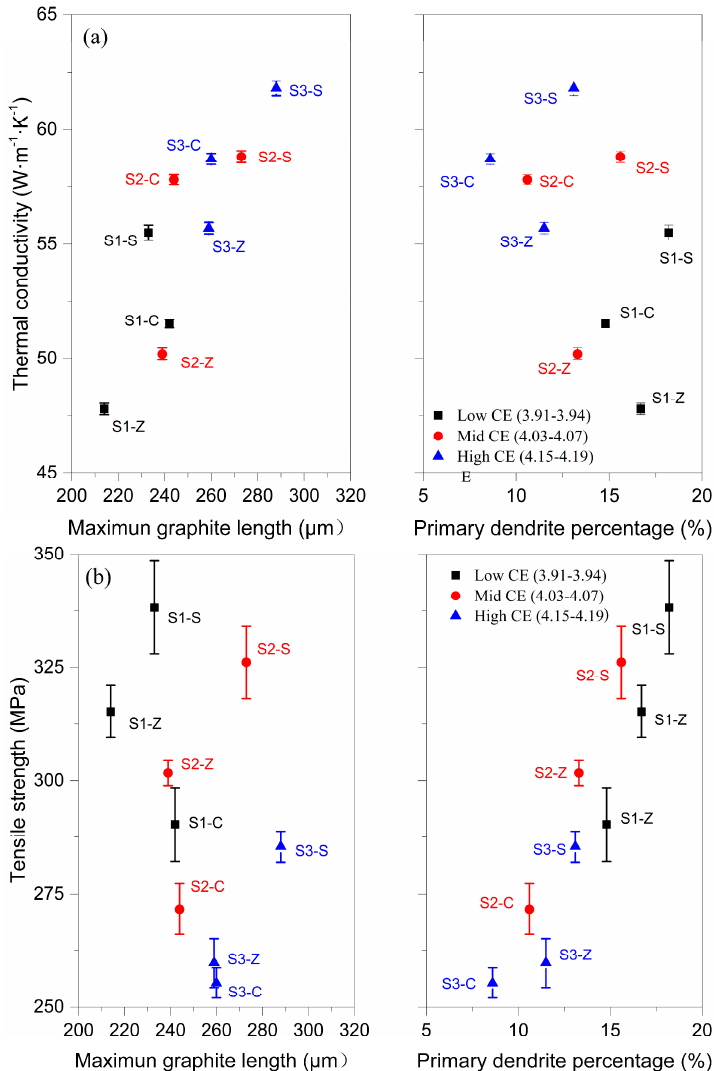
Figure 9. Relationship between the structural characteristics and properties: thermal conductivity ( a ) and tensile strength ( b ). Errors are ± one standard deviation.